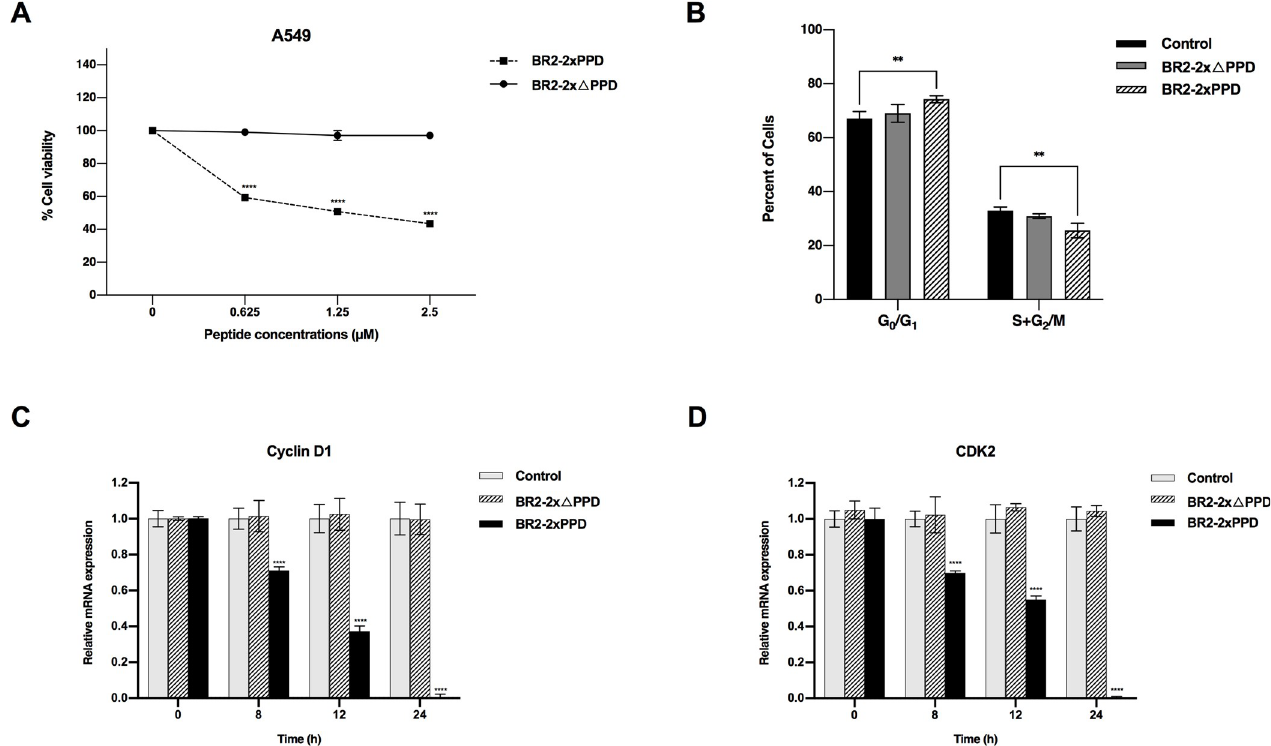
Fig 3. BR2-2xPPD peptide inhibited EGFR wild-type NSCLC growth. (A) Effect of BR2-2xPPD and BR2-2x Δ PPD peptide on EGFR wild-type A549 cell proliferation. A549 cells were cultured in 10%FBS-RPMI plus 1% PenStrep at 3,000 cells/well. After 24 h, cells were treated with increasing dose of BR2-2xPPD or BR2-2x Δ PPD (0, 0.625, 1.25 and 2.5 μ M) for 24 h. Cell viability was performed by MTT assays. Value are represented as means ± SEM (n = 3). Percent cell viability of peptide treatments were normalized with DMSO ( ���� p � 0.0001). (B) Cell cycle distribution assessed by flow cytometry. A549 cells were treated with BR2-2xPPD or BR2-2x Δ PPD peptide at concentration 2.5 μ M in 10%FBS-RPMI for 24 h. Cells were collected and analyzed by flow cytometry as described in Materials and Methods. Bar graphs represent changes in the percentage of cells in G 0 /G 1 and S+G 2 /M phase as compared with untreated cell (control). Results are shown as means ± SEM (n = 3) ( �� p � 0.01). (C) Relative Cyclin D1 and (D) CDK2 mRNA expression. A549 were cultured with BR2-2xPPD peptides at a concentration of 2.5 μ M in 10%FBS-RPMI for indicated time points shown in the x-axis. Total RNA was extracted and amplified by qRT-PCR. Values represent relative gene expression normalized with GAPDH. All data are reported as means ± SEM (n = 3) compared with control untreated cells ( ��� p � 0.001) ( ���� p � 0.0001).